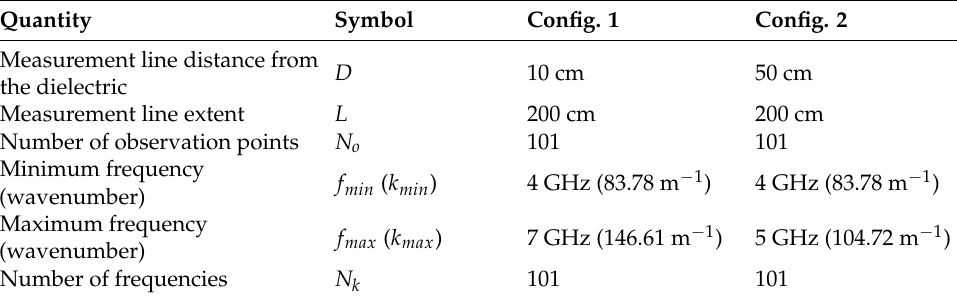
Table 1. Measurement configurations (see Figure 1).